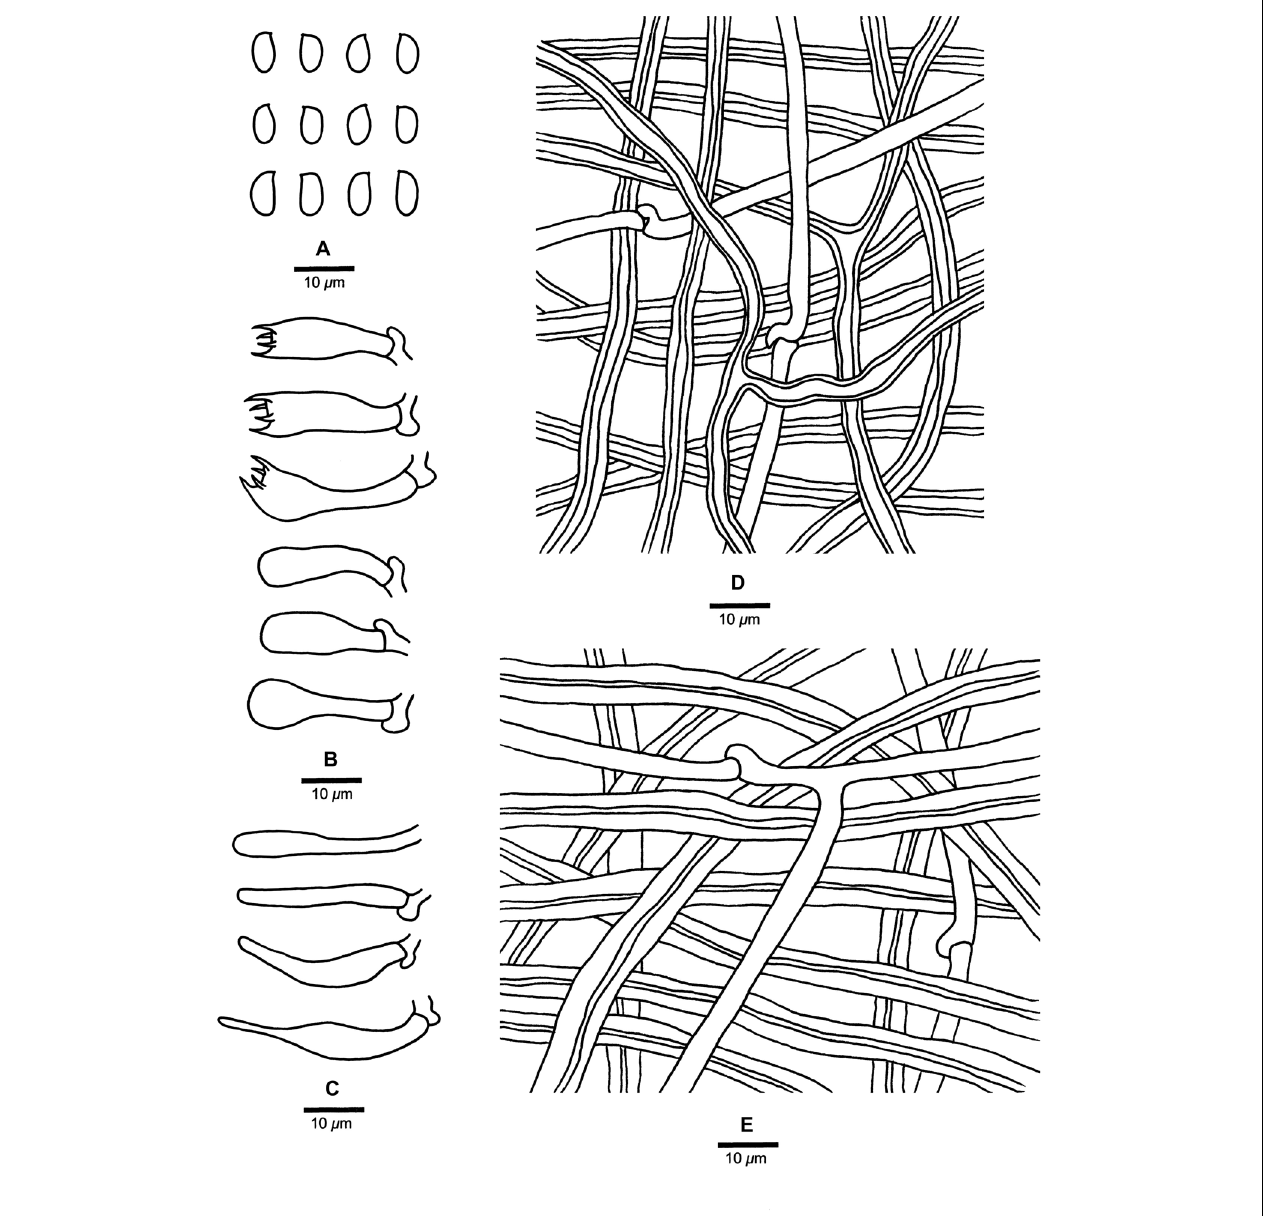
FIGURE 7 | Microscopic structures of Fomitopsis massoniana (drawn from the holotype). (A) Basidiospores; (B) Basidia and basidioles; (C) Cystidioles; (D) Hyphae from trama; (E) Hyphae from context. Bars: A–E = 10 µ m.